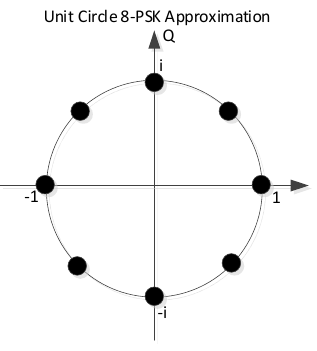
Figure 10. Algorithmic idea of ICARUS joint timing and Doppler sync.